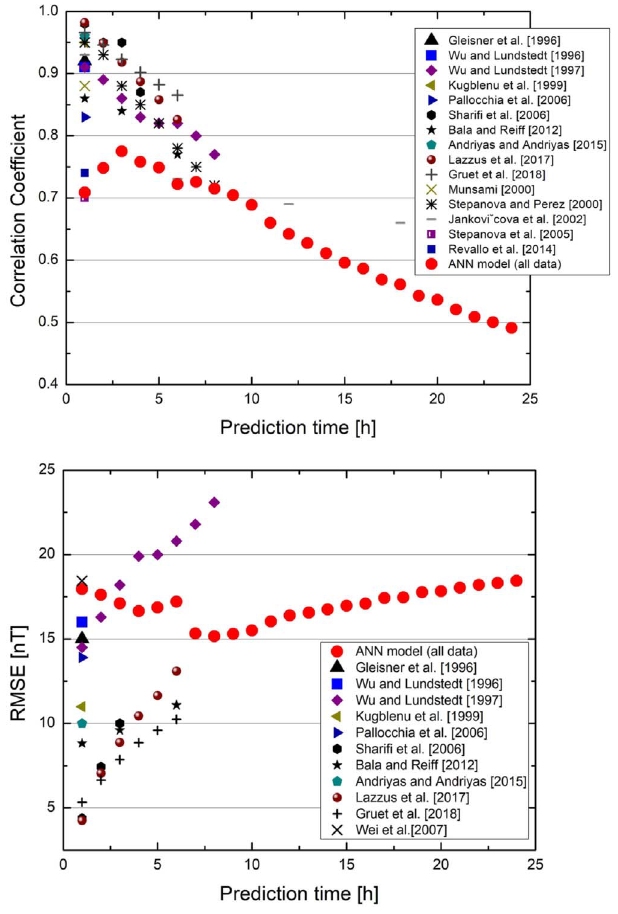
Fig. 2. Comparison of the simple ANN model performance with other models: correlation coef fi cient (up) and RMSE (down) derived for test